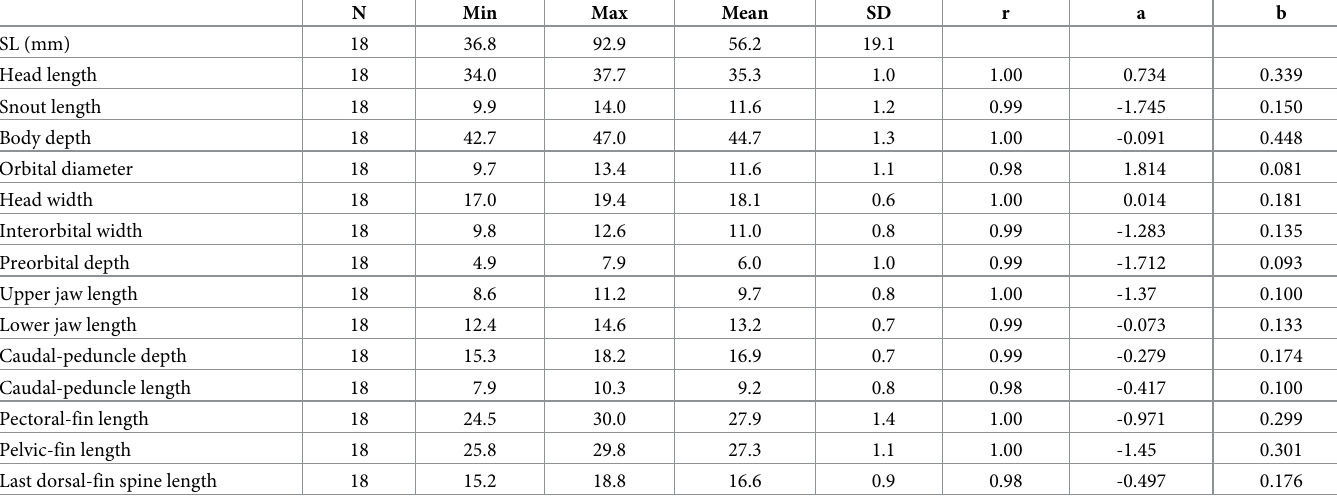
Table 13. Australoheros minuano from Uruguay. Size (SL), proportional measurements (per cent of SL), and linear regression parameters. N Min Max